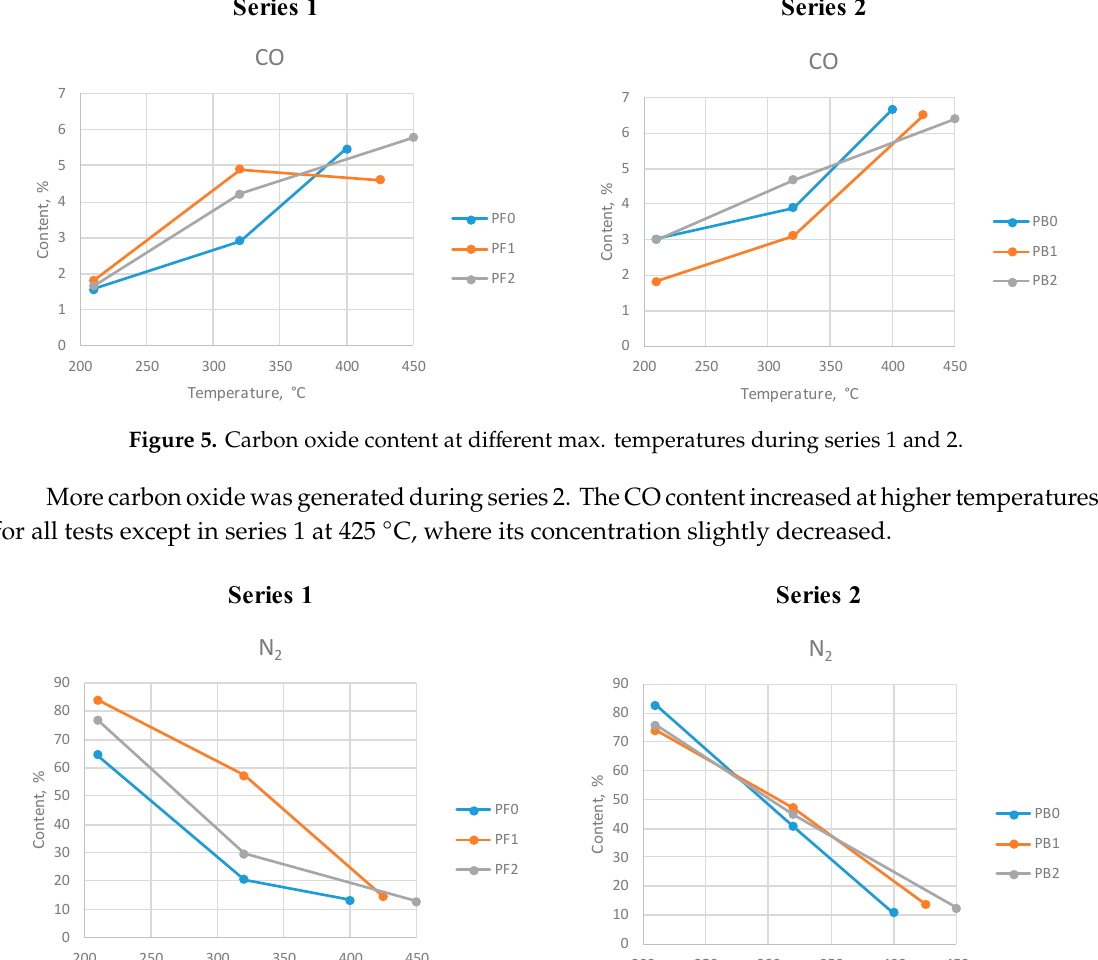
Figure 6. Nitrogen content at di ff erent max. temperatures during series 1 and